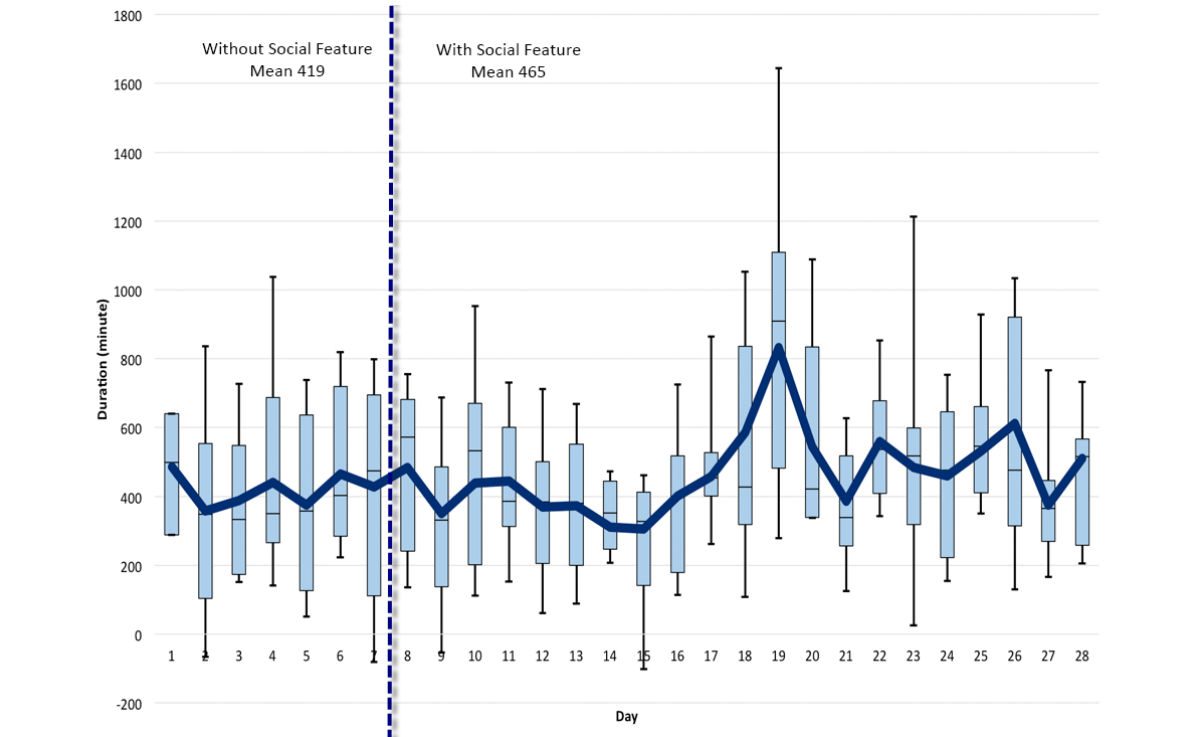
Figure 11. Duration of system usage comparison between baseline and social intervention.